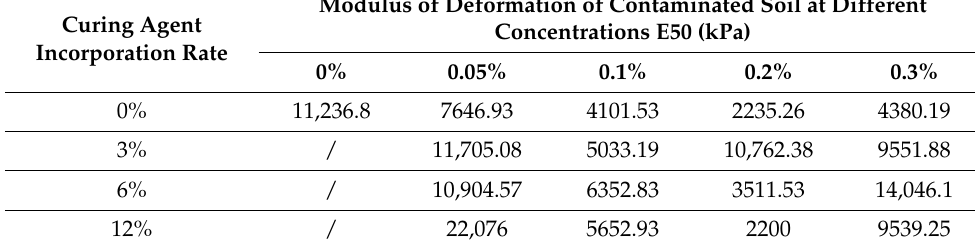
Table 3. Deformation modulus of cured soil at different contamination concentrations E50.